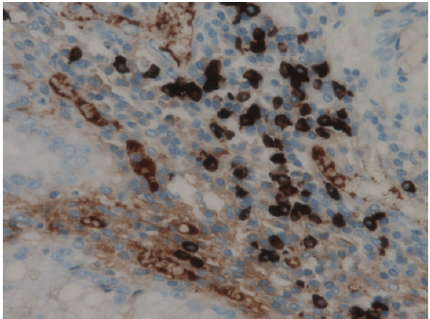
Figure 13: “Conventional” tubular adenoma of the colon with low- grade dysplasia, with focal dilation of crypts (hematoxylin-eosin, original magnification 2x).